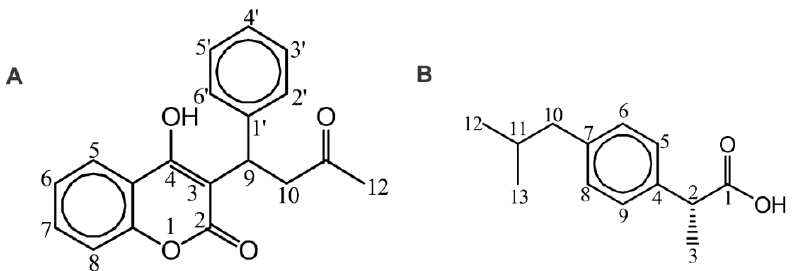
Figure 4. Chemical structures of warfarin ( A ) and ibuprofen ( B ) with the numbering of atoms.